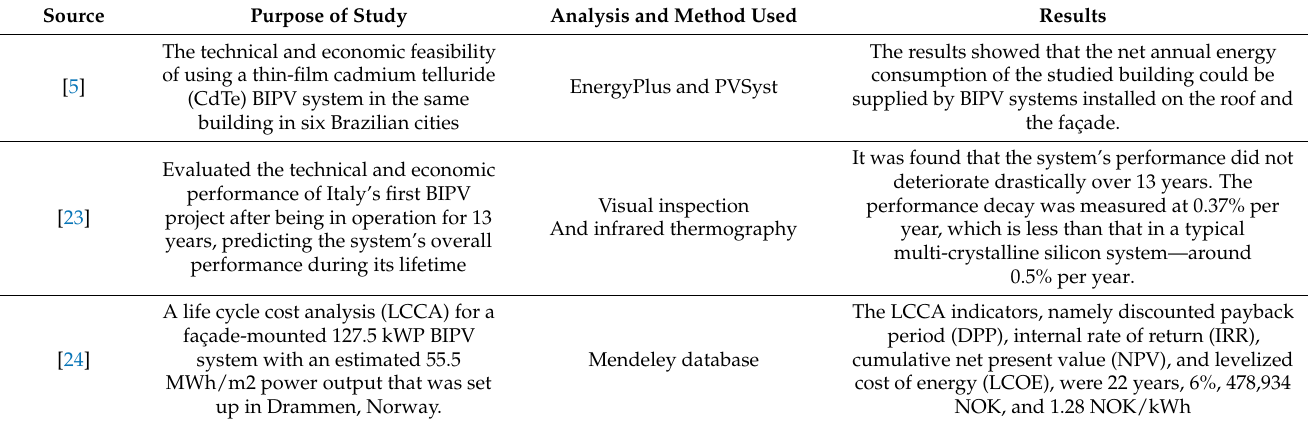
Figure 5. Classification of BIPV products [21].